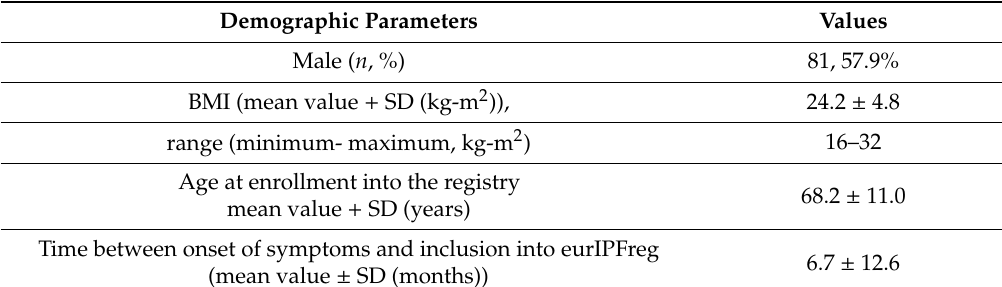
Table 1. Clinical characteristic of the unclassifiable interstitial lung diseases (uILD)